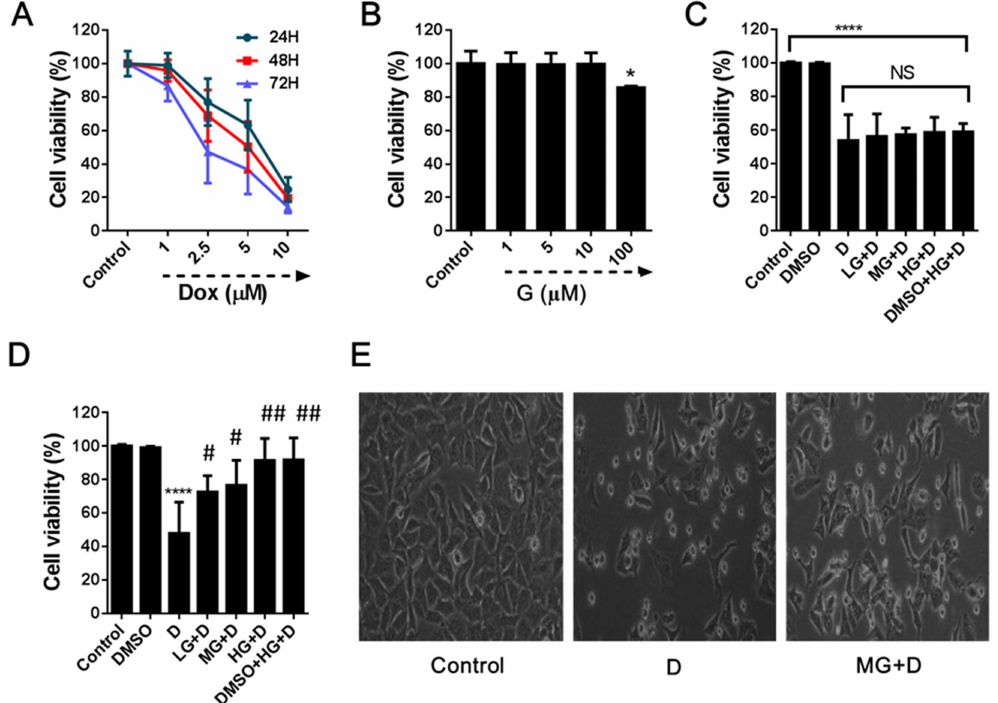
Fig 1. Protectiveeffect of GB against DOX-induced cardiac cell death. ( A ) Time and dose-dependentDOX- inducedcardiaccell death was determinedby MTT assay. ( B ) The safety dosageof GB on the cardiomyocytes viabilitywas assessed by MTT assay. ( C ) Cardiomyocytes were treated with low (LG, 1 μ M)medium (MG, 5 μ M) and high (HG, 50 μ M) of GB after DOX treatment for 3 h and no improvement was found on the cardiomyocytes viabilityin DOX inducedcardiotoxicity. ( D ) Pretreatment with low (LG), medium (MG) and high (HG) doses of GB for 30 min prior to DOX-induced cardiotoxicity increasedcardiomyocytes viability. ( E ) Representative images of the effects of DOX and pretreatmentwith GB for 30 min on cardiomyocytes proliferation. **** p < 0.0001 when comparedto control group, #p < 0.01,##p < 0.001when comparedto